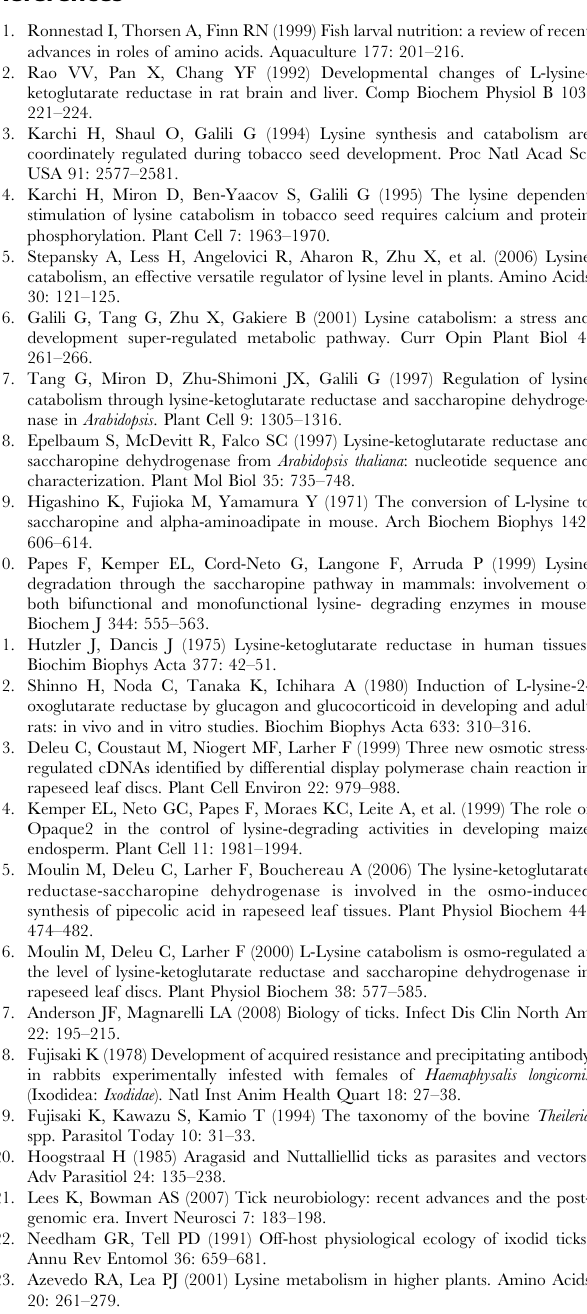
Figure S2 Alignment of the amino acid sequence with various species of LKR/SDH. The deduced amino acid sequence of